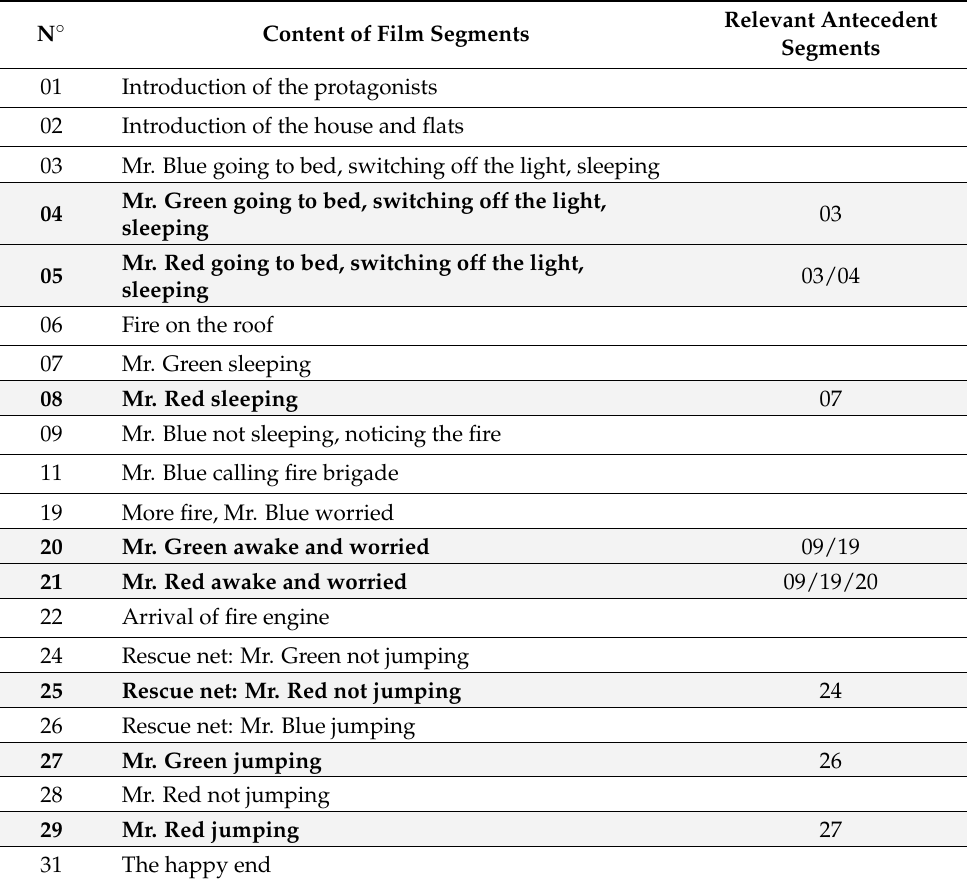
Table 2. The Finite Story : additive segments selected for analysis and relative antecedents. N